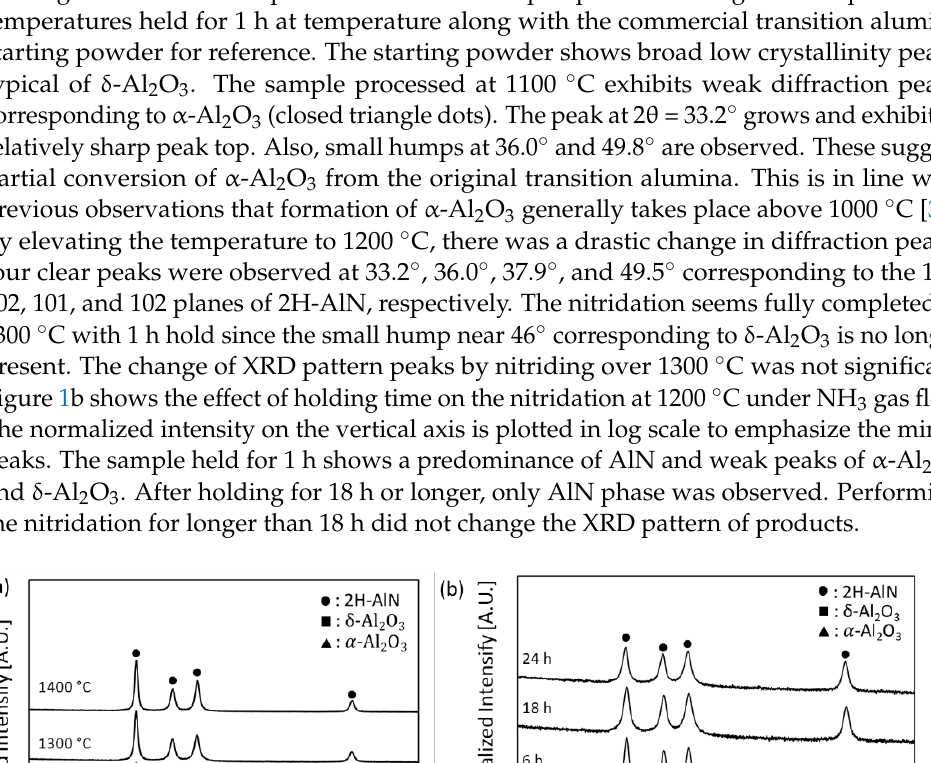
Figure 2. SEM micrographs of nanopowders. ( a ) unreacted δ-Al 2 O 3 . Samples nitrided at ( b ) 1100 °C, ( c ) 1200 °C ( d ) 1300 °C, and ( e ) 1400 °C for 1 h. ( f ) is 1200 °C for 18 h. The effect of temperatures on grain size is more clearly appreciated in Figure 3a which plots average grain size vs. nitridation temperature. At 1100 °C, the measured grain size was ~70 nm which increased to ~200 nm at 1400 °C. The 𝑑̅ of samples processed at 1100 °C and 1200 °C are below 100 nm which is important for attaining dense nano-AlN.